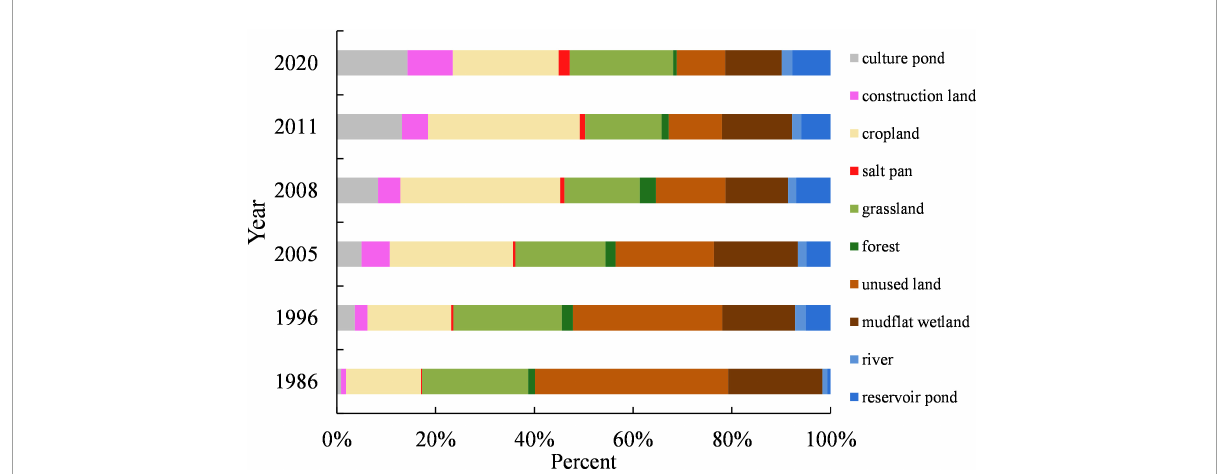
FIGURE5 Changes in the area proportion of different land-use types in the Yellow River Delta